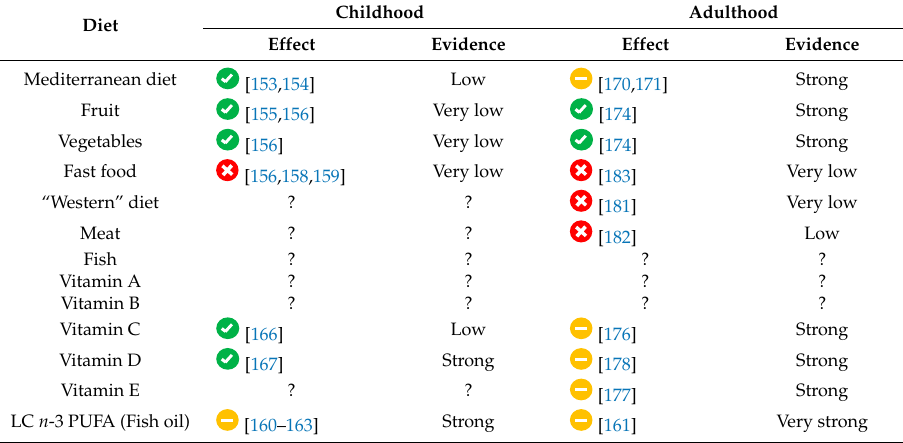
Beneficial effect; negative effect; Beneficial effect; negative effect; No Table 1. Diet and risk of asthma or wheezing. Beneficial effect; negative effect; Table 1. Diet and risk of asthma or wheezing. Beneficial effect; negative effect; Table 1. Diet and risk of asthma or wheezing.